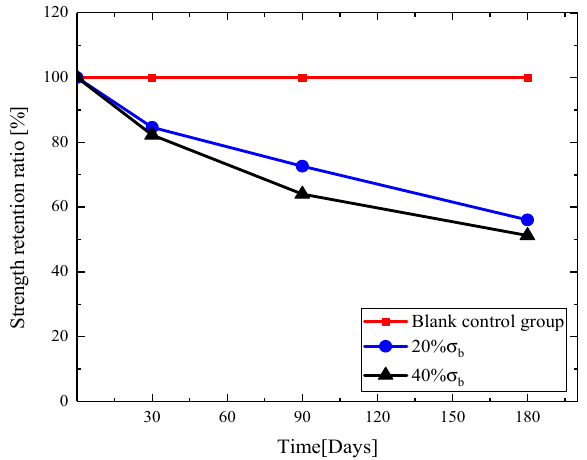
Figure 6. Tensile strength retention ratio of GFRP bars under different loadings.